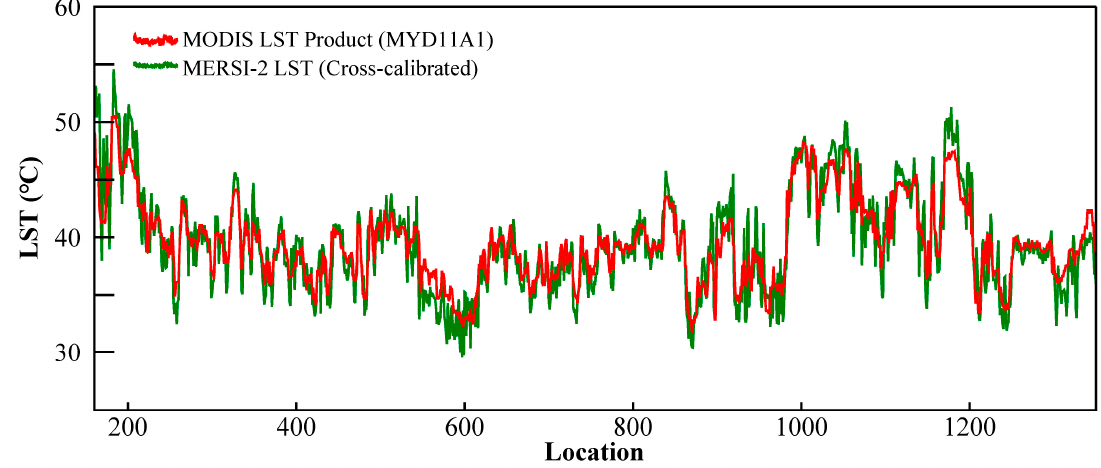
Figure 14. LST profiles of the MERSI-2 image and MODIS LST product (MYD11A1).